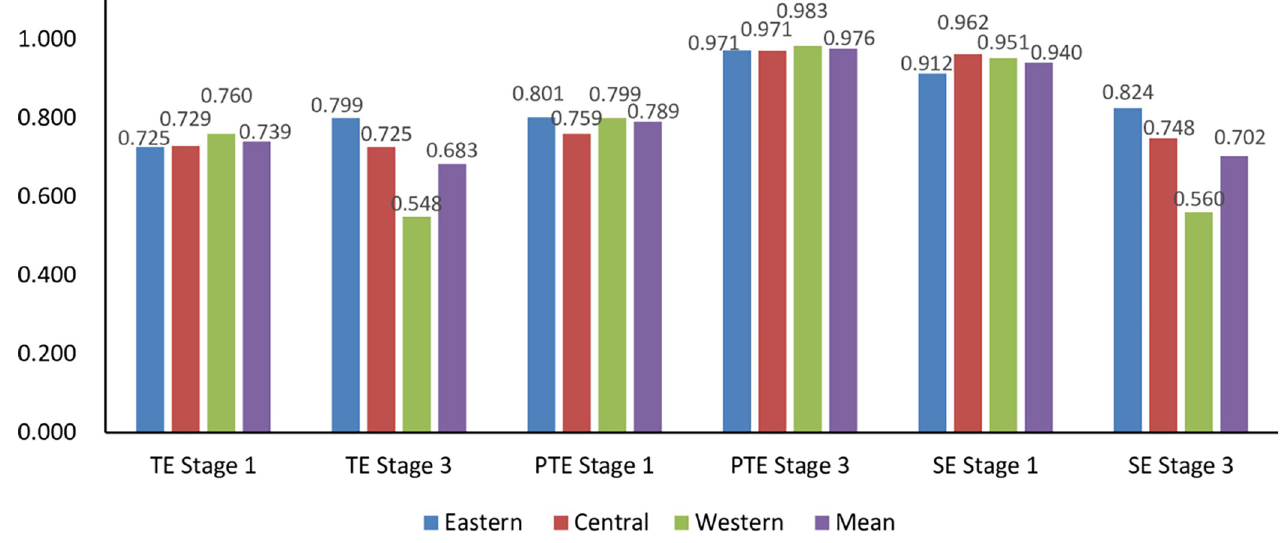
Fig 4. Comparison of the efficiency in different regions in Stage 1 and Stage 3.